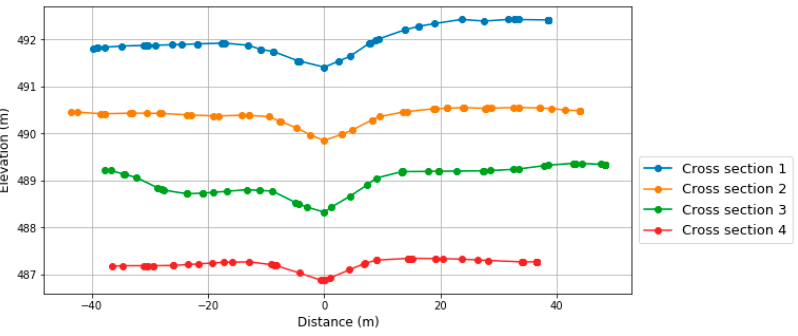
Figure 14. Cross section in different points of the main channel from the DEM. Additionally, the distance between the off-stream reservoir and the channel (B l ) was measured from the location of the main channel and the reservoir. Table 7 shows the estimated terrain parameters. A database with the 15 inputs for each AoI (B l , S lb , S lc , S t , L B